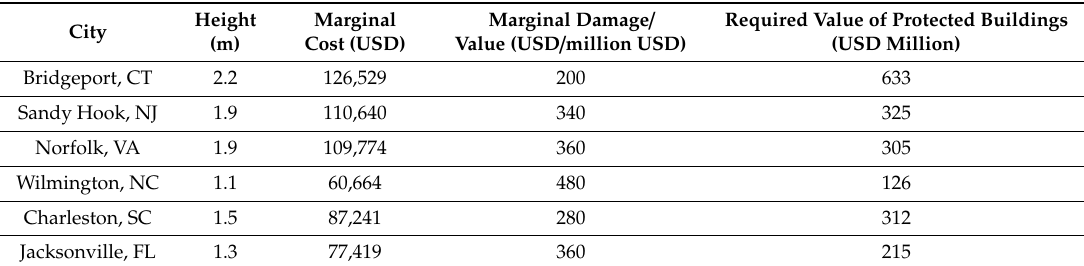
Figure 2. Height and Probability of 100-Year-Surge. Table 1. Minimum Value of Protected Buildings That Justify Wall Height to Stop a 100-Year Storm Surge (Wall length 100